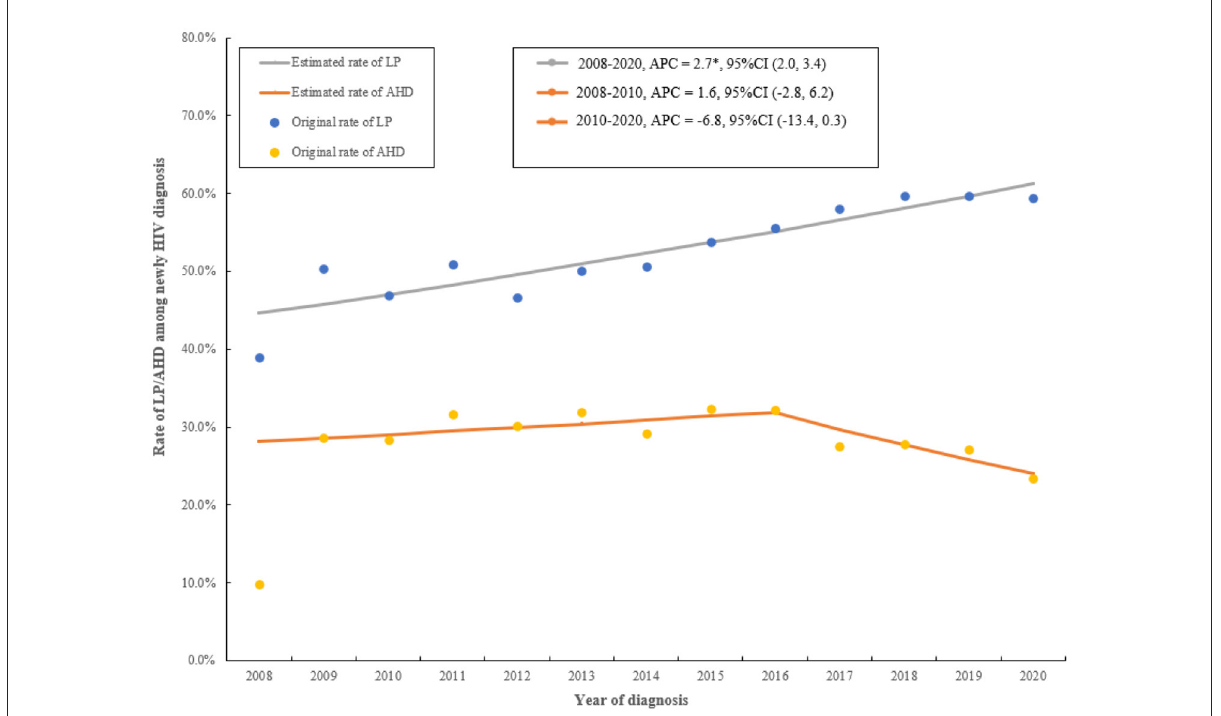
FIGURE2 The trends of original and estimated rate for LP and AHD from 2008 to 2020, in Jiangsu, China. LP, late presentation; AHD, advanced HIV disease; APC, annual percentage change; CI, confidence interval; * P <